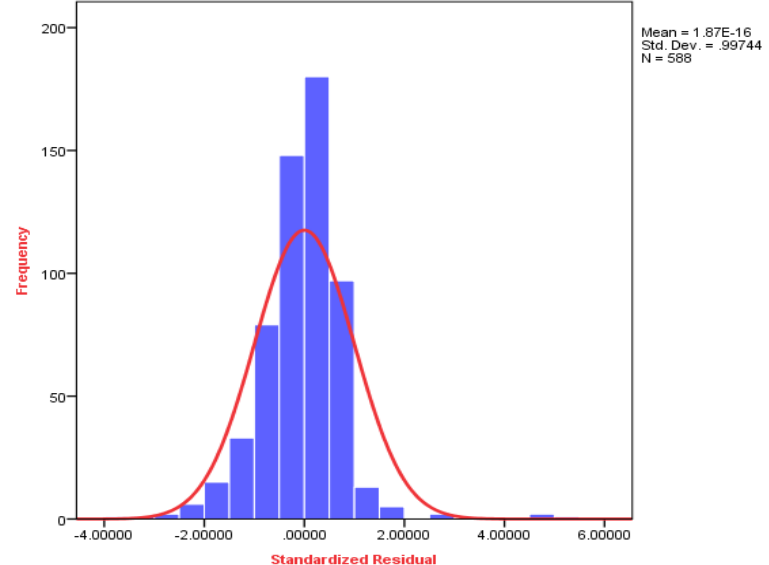
Figure 4. Figure 4. Histogram.